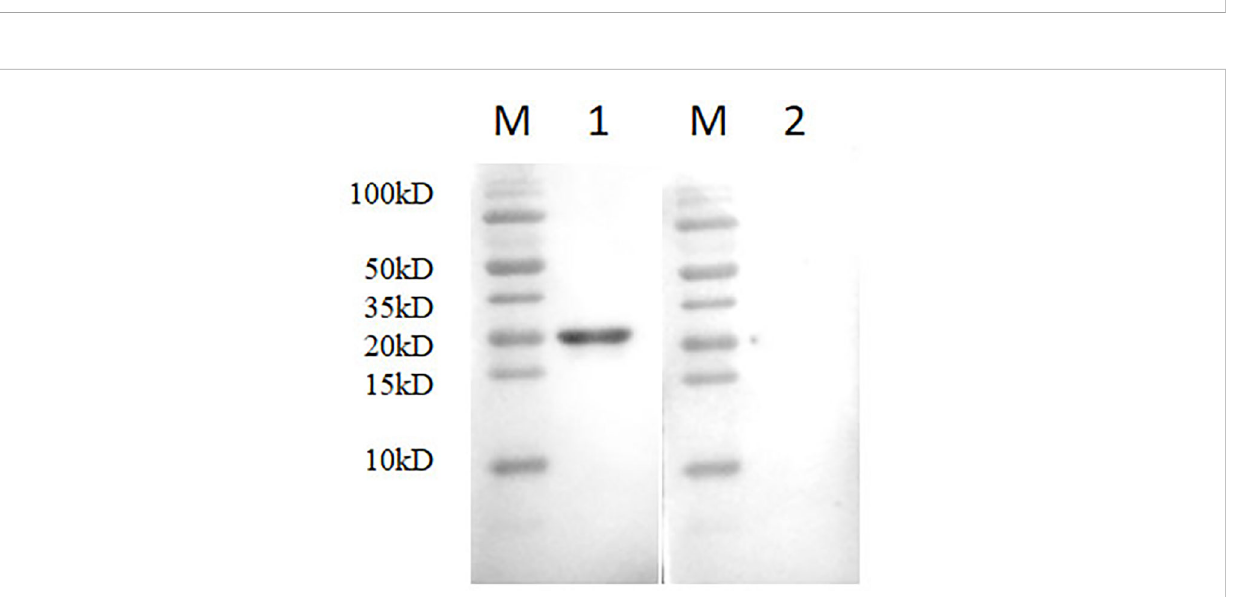
FIGURE 2 Western blotting analysis using mAb N06. Lane M, protein marker; lane 1, monoclonal antibody N06; lane 2, porcine reproductive and respiratory syndrome virus (PRRSV)-negative serum.